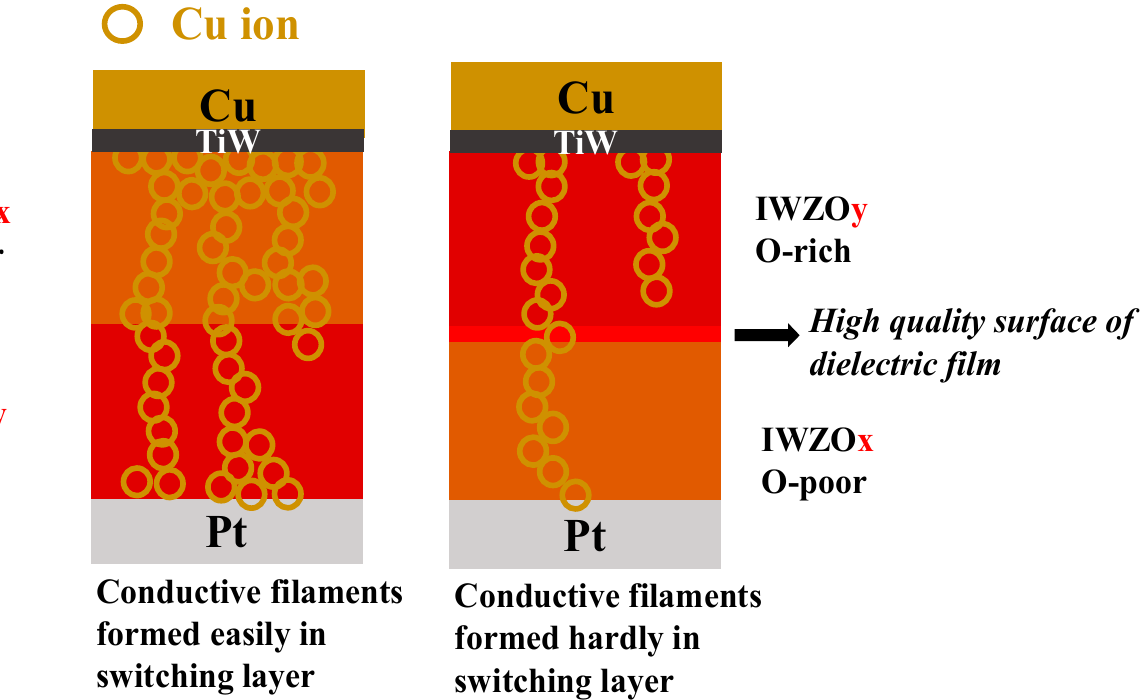
Figure 5. Schematic diagram of the behavior of conductive filaments in the bilayer IWZO CBRAM during device opera- tion.